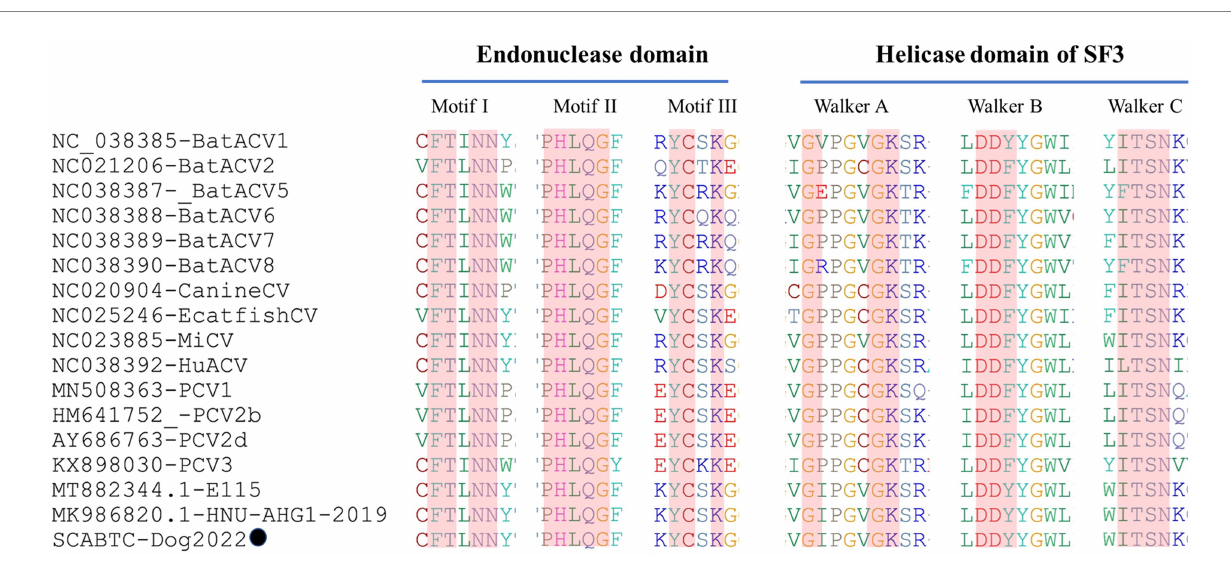
FIGURE 4 The N-terminal endonuclease domain and the helicase domain of superfamily 3 (SF3) described by Nguyen et al. (2022), were also observed in SCABTC- Dog2022. proposed by Fux et al. The black solid circle ( ● ) represented the dog-derived PCV4 strain (SCABTC-Dog2022) in this